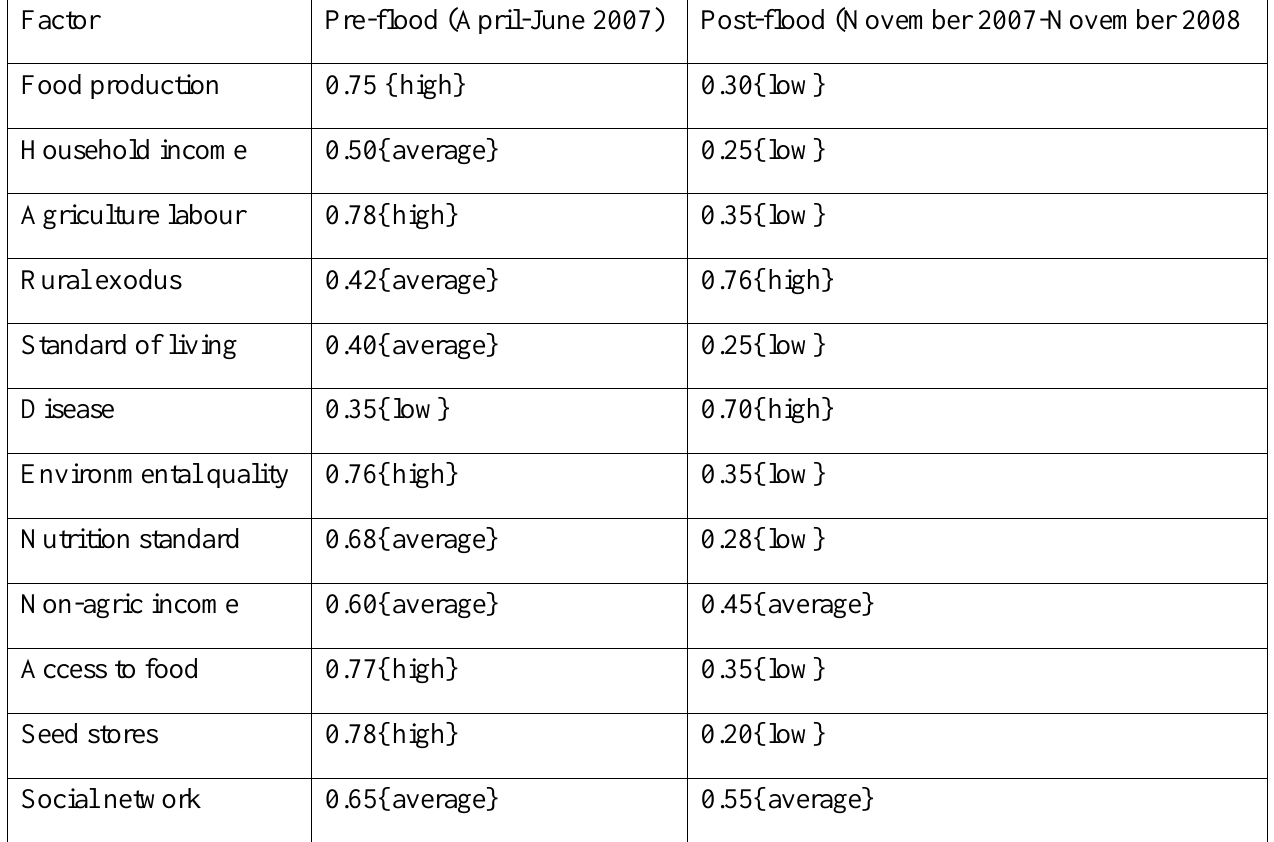
Table 2. Ranking of factors in the loops (indicators of vulnerability and